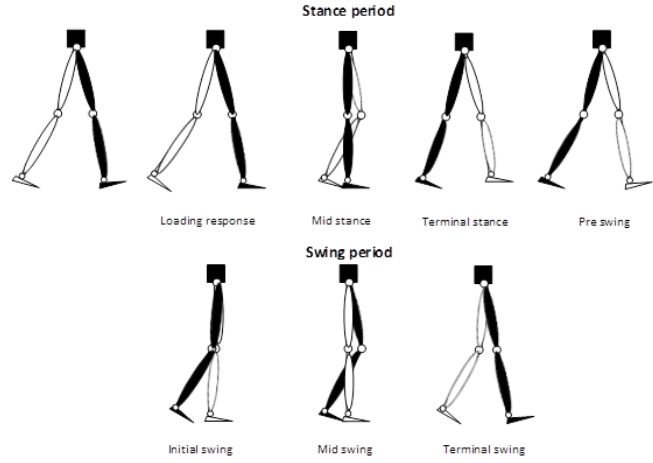
Figure 1. A typical human gait